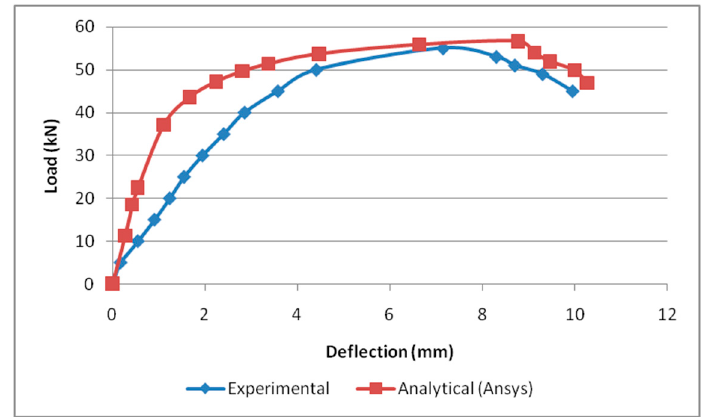
Figure 18. Load vs. deflection for F2F100.